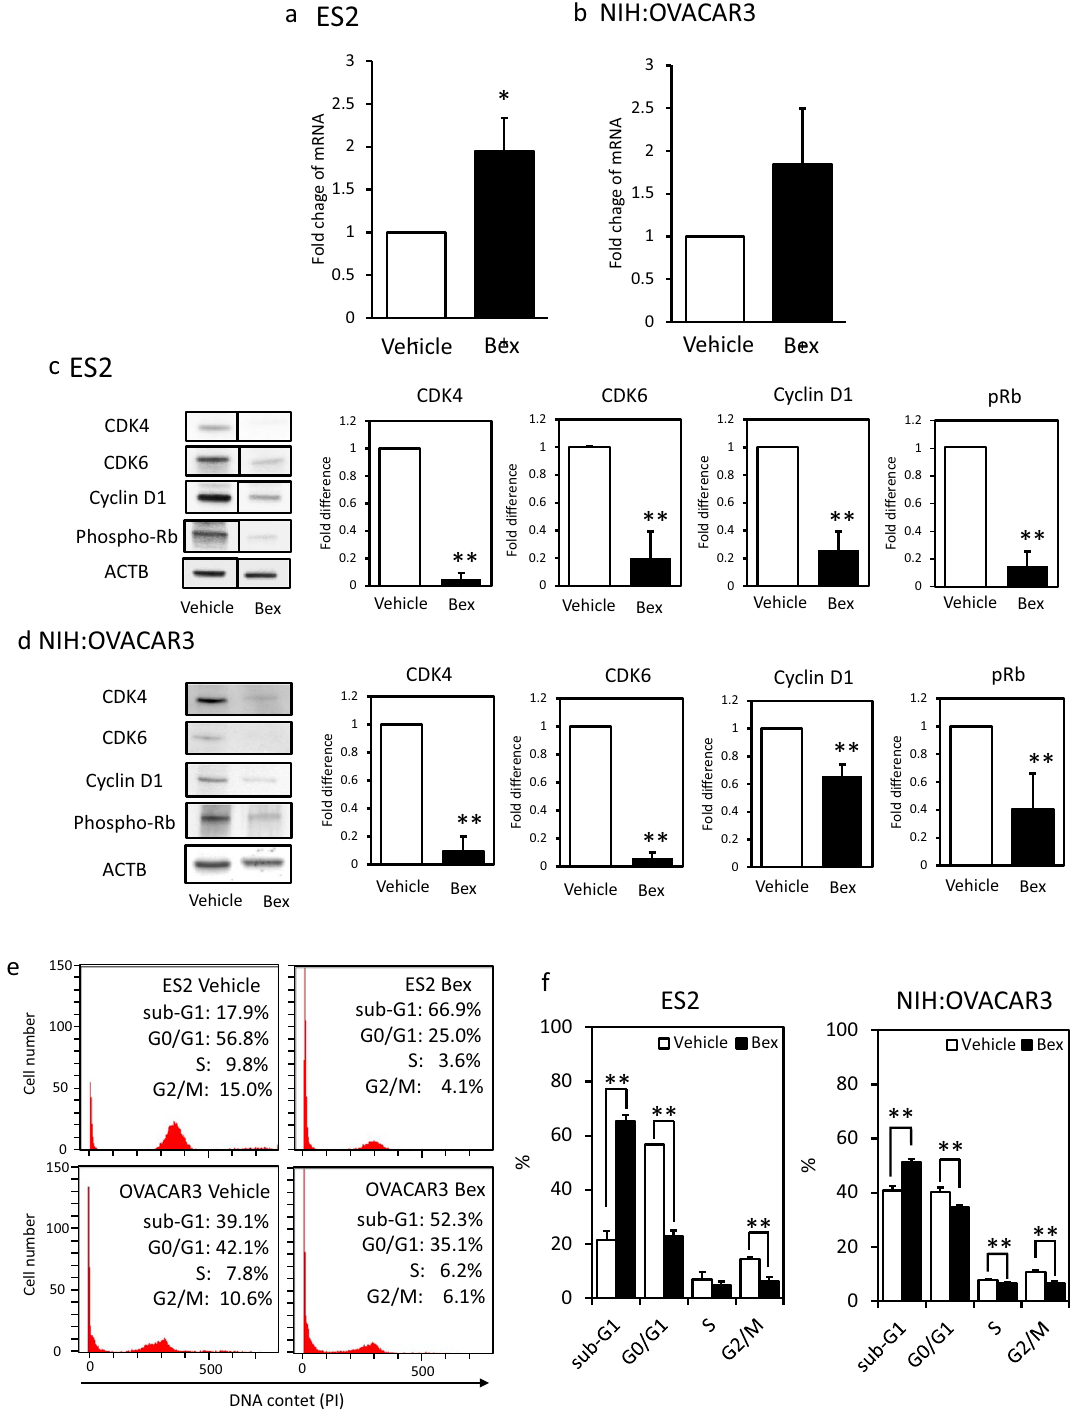
Figure 2. Bexarotene treatment increased CDKN1A mRNA expression, decreased cell cycle-related proteins, and increased the sub-G1 phase cell population. Levels of CDKN1A mRNA were measured and compared between 10 µM bexarotene-treated cells and nontreated cells 24 h after bexarotene treatment in ( a ) ES2 and ( b ) NIH:OVACAR3 cells. CDKN1A expression was assessed using the 2-ΔΔCT quantitation method and normalized to housekeeping gene GAPDH using a no-treatment control as a calibrator. The results presented were mean, ± standard deviation for at least three independent experiments. ( c , d ) Western blot analysis was performed to evaluate the effect of 10 µM bexarotene on cell cycle-related proteins (CDK4, CDK6, cyclin D1, and phospho-Rb) in ES2 and NIH:OVACAR3 cells. Used as an internal control was β-actin. Columns and bar graphs represent the mean ± standard deviation for at least three independent experiments. Quantification of protein levels was performed by densitometry and normalized to β-actin. ( e , f ) Cell cycle analysis with PI-stained cells. Bexarotene (10 µM ) treatment significantly increased the sub-G1 phase cell population and reduced G0/G1 and G2/M phase population in both the cell lines. White bars and the black bars represent the data in the vehicle- and 10 μM–bexarotene treated cell, respectivery. * P < 0.05, ** P < 0.01, compared with bexarotene-free control. ACTB,